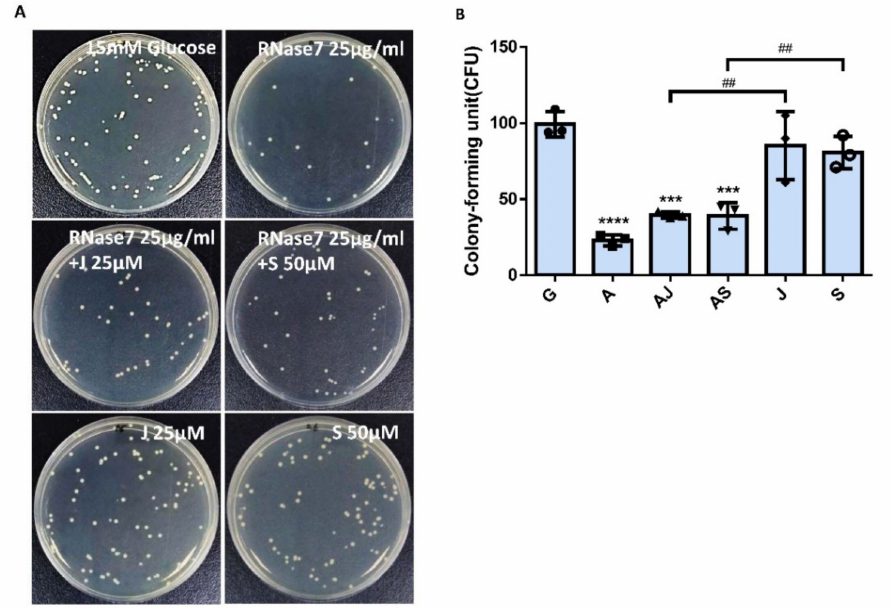
Figure 7. JAK and STAT inhibitors affected the suppression of RNase 7 in UPEC-infected bladder cells in a high-glucose environment. SV-HUC-1 cells were pretreated with 25 µ g/mL RNase 7 and simultaneously with 25 µ M JAK inhibitor or 50 µ M STAT inhibitor for 24 h, followed by UPEC infection (MOI:100) as described above. Cells pretreated with 25 µ M JAK inhibitor or STAT3 inhibitor alone for 24 h followed by UPEC infection were used as respective controls. Cells infected with 15 mM glucose and UPEC alone were used as the respective positive controls. The definitions of each letter represented by the X axis are: C: control; G: with 15 mM glucose pretreatment alone; A: pretreated with 25 µ g/mL RNase 7; AJ: coincubated with 25 µ g/mL RNase 7 and 25 µ M JAK inhibitor; AS: coincubated with 25 µ g/mL RNase 7 and 50 µ M STAT inhibitor; J: cells pretreated with 25 µ M JAK inhibitor alone; S: Cells pretreated with STAT inhibitor alone. The picture shown is representative of a typical result. Twenty-four hours post-infection, all infected cells were ( A ) lysed and plated on LB agar and ( B ) measured using ImageJ software to analyze UPEC colonization. Colony-forming units (CFUs) were acquired after plating 10-fold dilutions of infected cells with lysis. Data are expressed as mean ± SD of three separate experiments. *** p < 0.001, **** p < 0.0001, compared to UPEC infection control groups. ## p < 0.01, compared between the two indicated